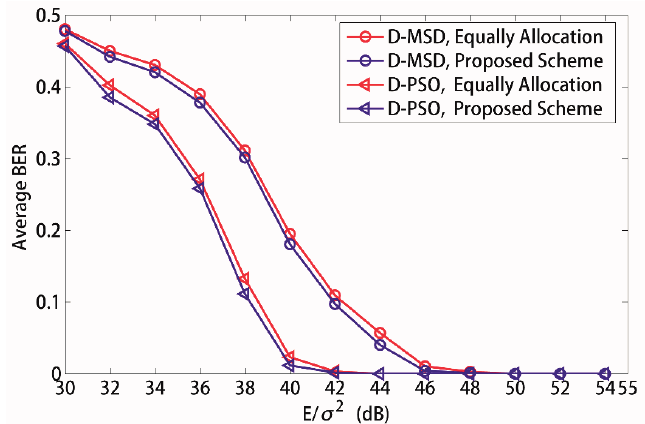
Figure 7. Influence of different power allocation scheme to the average BER. K = 8, N c = 256.